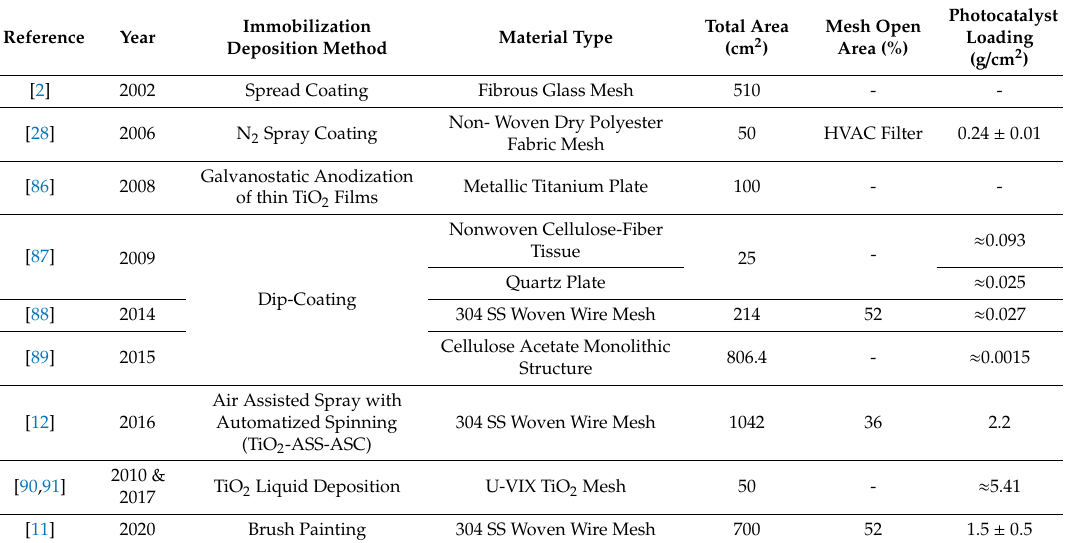
Table 3. Comparison of photocatalyst deposition methods using di ff erent types of supports.